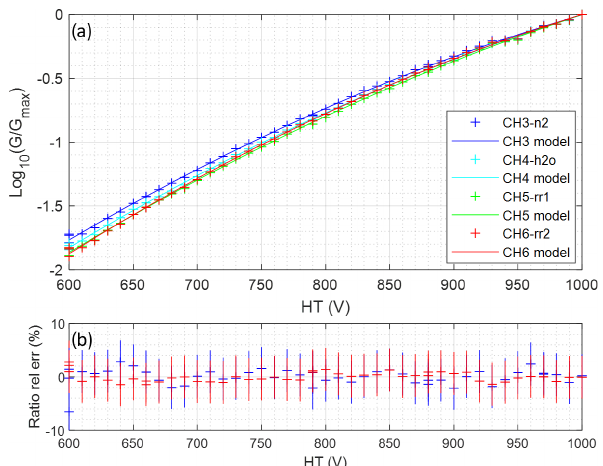
Figure 10. Calibration of PMT gain G versus control voltage U : (a) log-gain measurements and second-degree polynomial model for all Raman channels and (b) relative gain ratio error between model and measurements for vibrational and rotational Raman channel ratios.